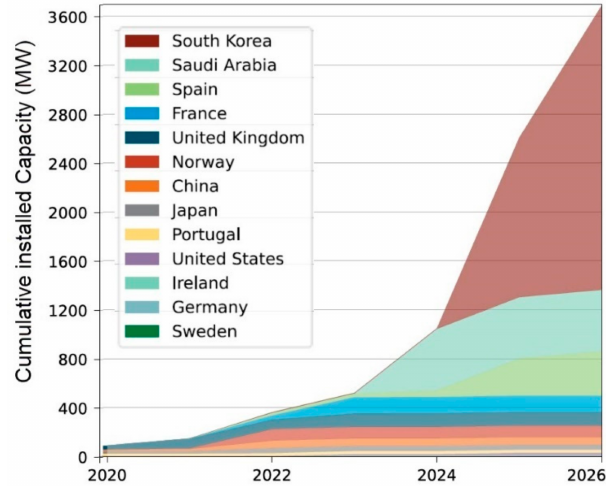
Figure 9. Cumulative floating offshore wind capacity